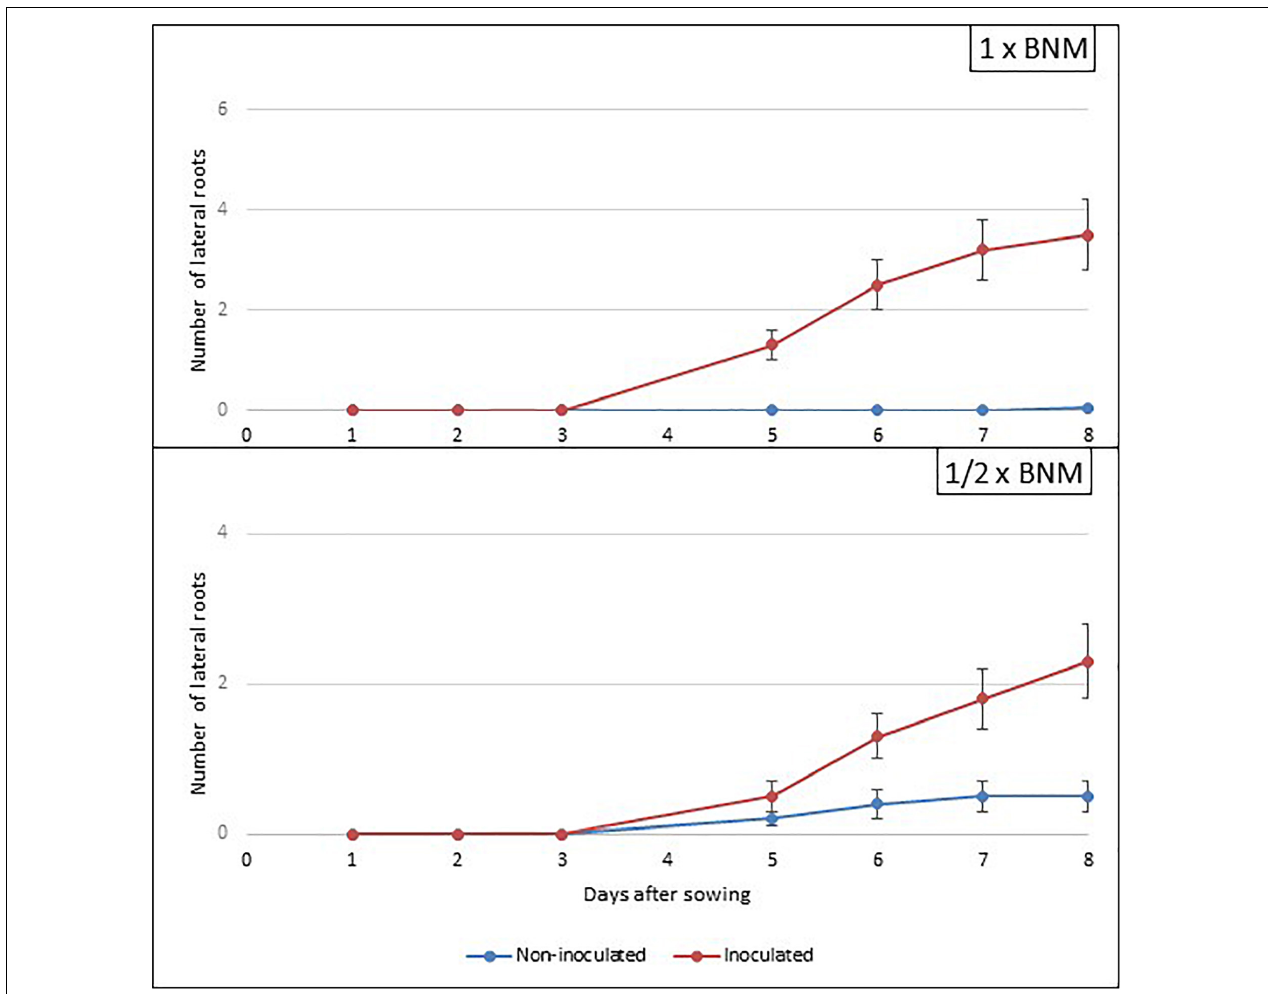
FIGURE 2 | Kinetics of appearance of secondary roots in non-inoculated and inoculated plants of Medicago sativa grown in vitro in square plates. Values represent mean ± SE, n = 24. TABLE 2 | Length of the primary root of alfalfa plants grown on 1 × BNM (normal concentration of nutrients) and 1/2 × BNM (half nutrients) and inoculated or non-inoculated with P. agglomerans RSO7. Plant growth medium Inoculation conditions Root length (cm)